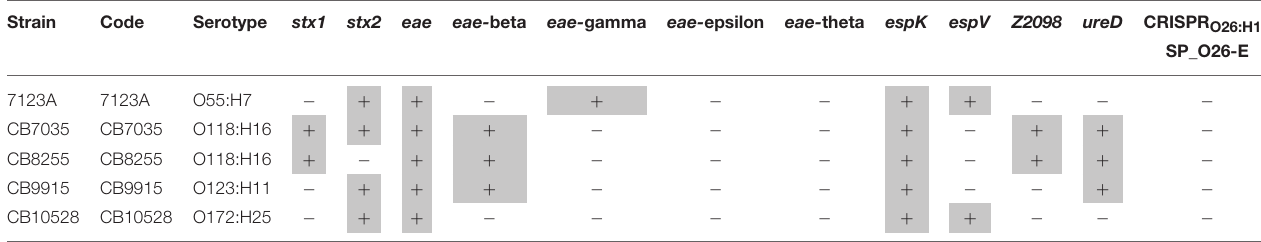
Table 1 . Overall, the genetic markers investigated were